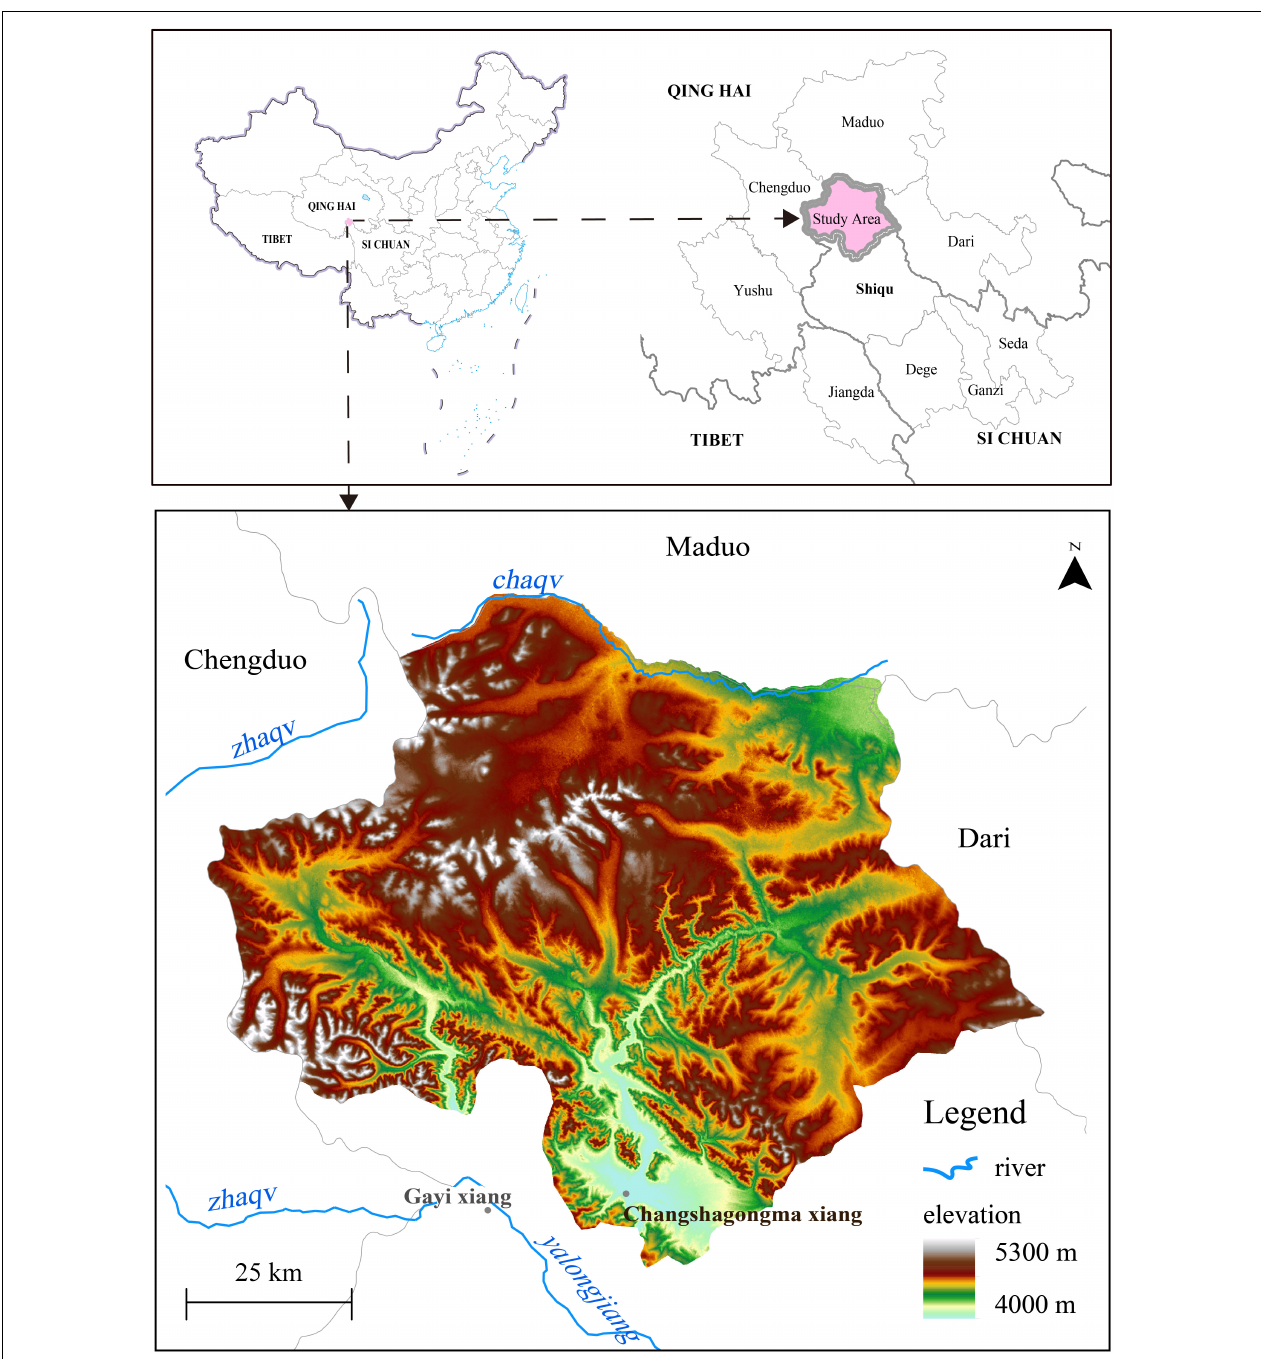
FIGURE 1 | Geographical location of the Changshagongma Wetland Nature Reserve.